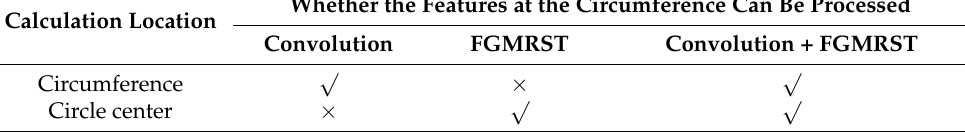
Table 1. Comparison of three